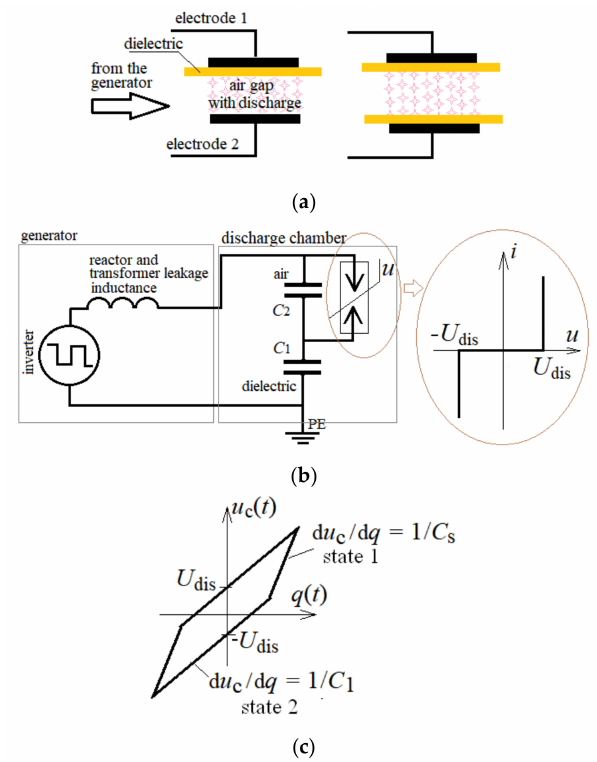
Figure 4. The idea of the construction of discharge chambers ( a ), simplified diagrams of the generator and the discharge chamber ( b ), and the trajectory of the voltage on the electrodes as a function of the charge supplied to these electrodes ( c